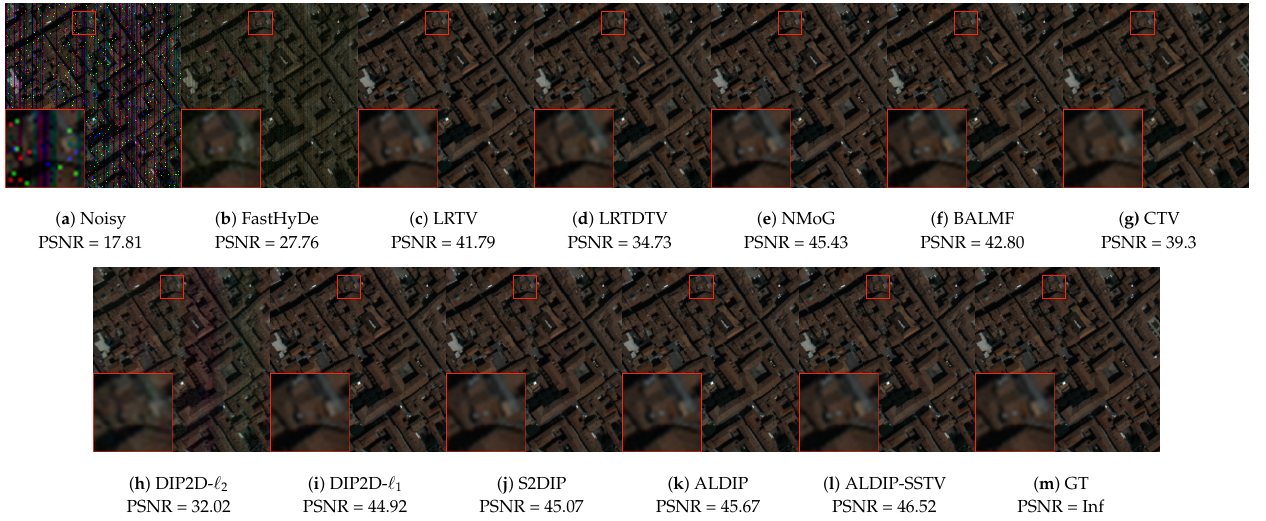
Figure 5. GT, noisy and denoising results by methods for comparison on Pavia Centre dataset (case 12). The pseudo images that consisted of the 30th, 14th and 2nd bands are selected to display. A local area (red square) is demarcated zoomed for easy